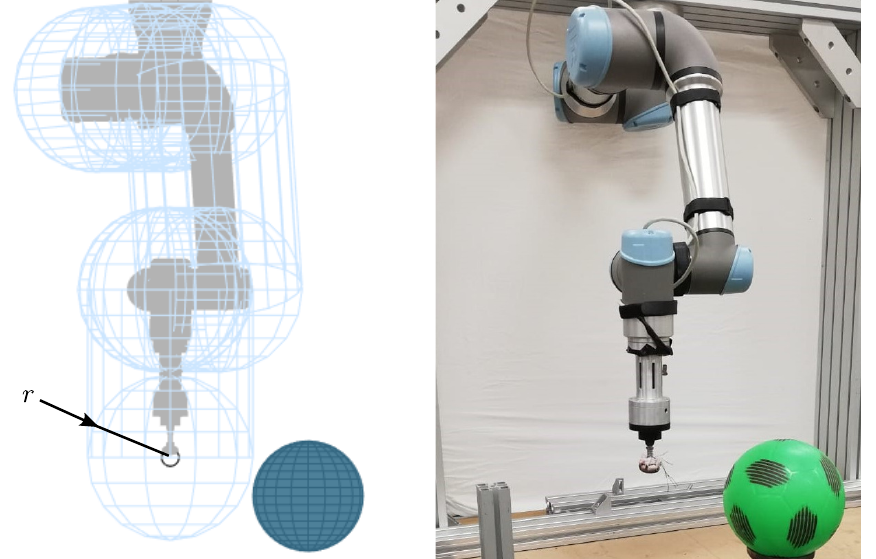
Figure 3. Simulated ( left ) and real ( right) test